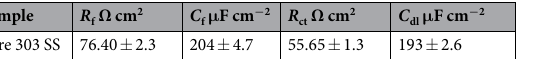
Table 3. Fitted electrochemical parameters of 303 SS in 1.0 M H 2 SO 4 solution at 298 K.